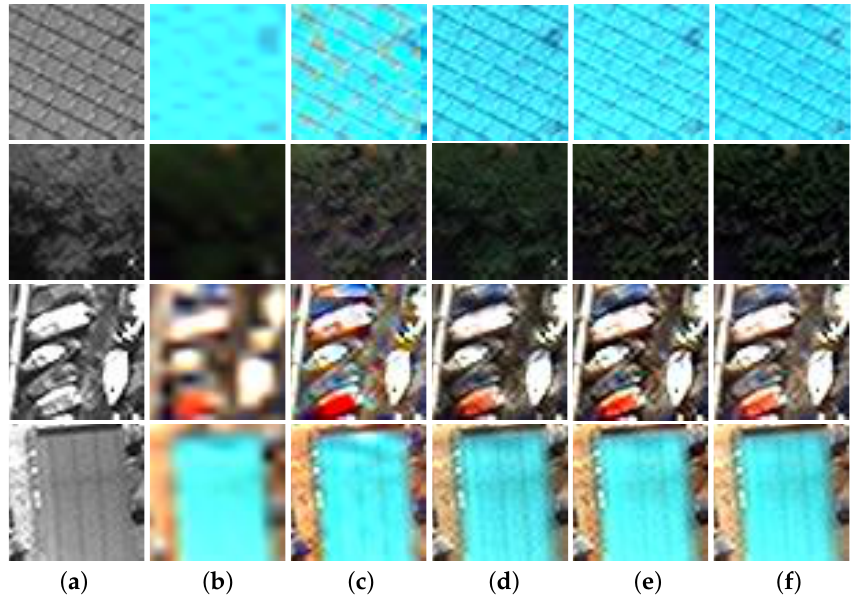
Figure 11. Visualization of local details of WorldView-3 test images: ( a ) PAN; ( b ) MS; ( c ) BDSD;